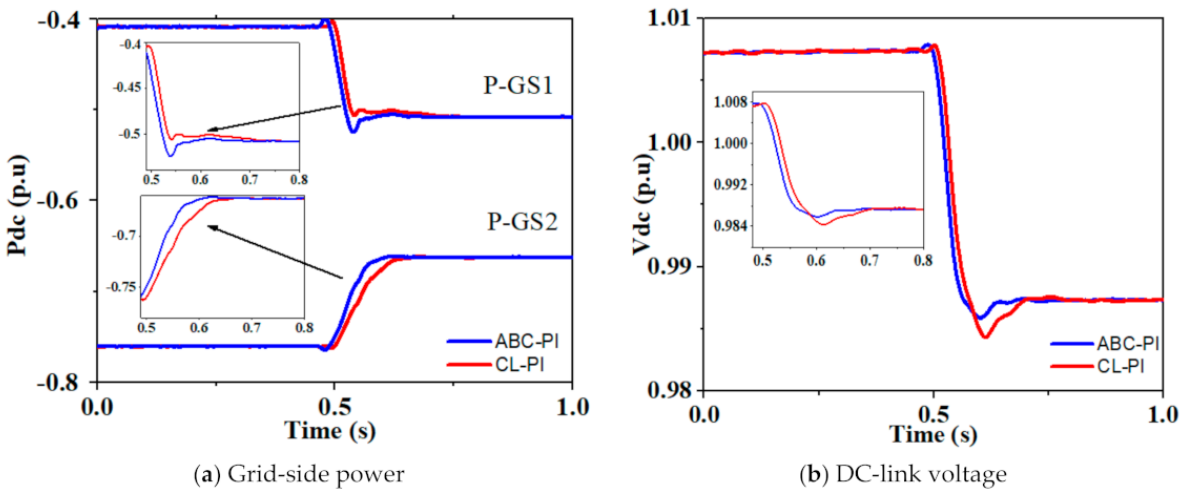
Figure 15. ( a ) Grid-side power, ( b ) DC-link voltage during unbalance load demand at on-shore